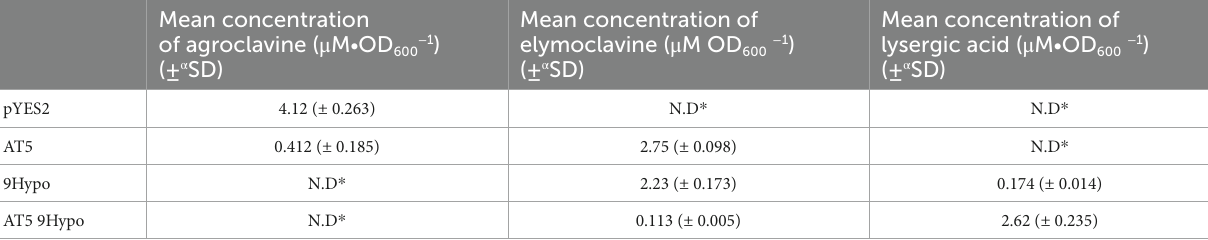
TABLE 2 Summary of the activity of AT5 9Hypo cloA in the presence of agroclavine.